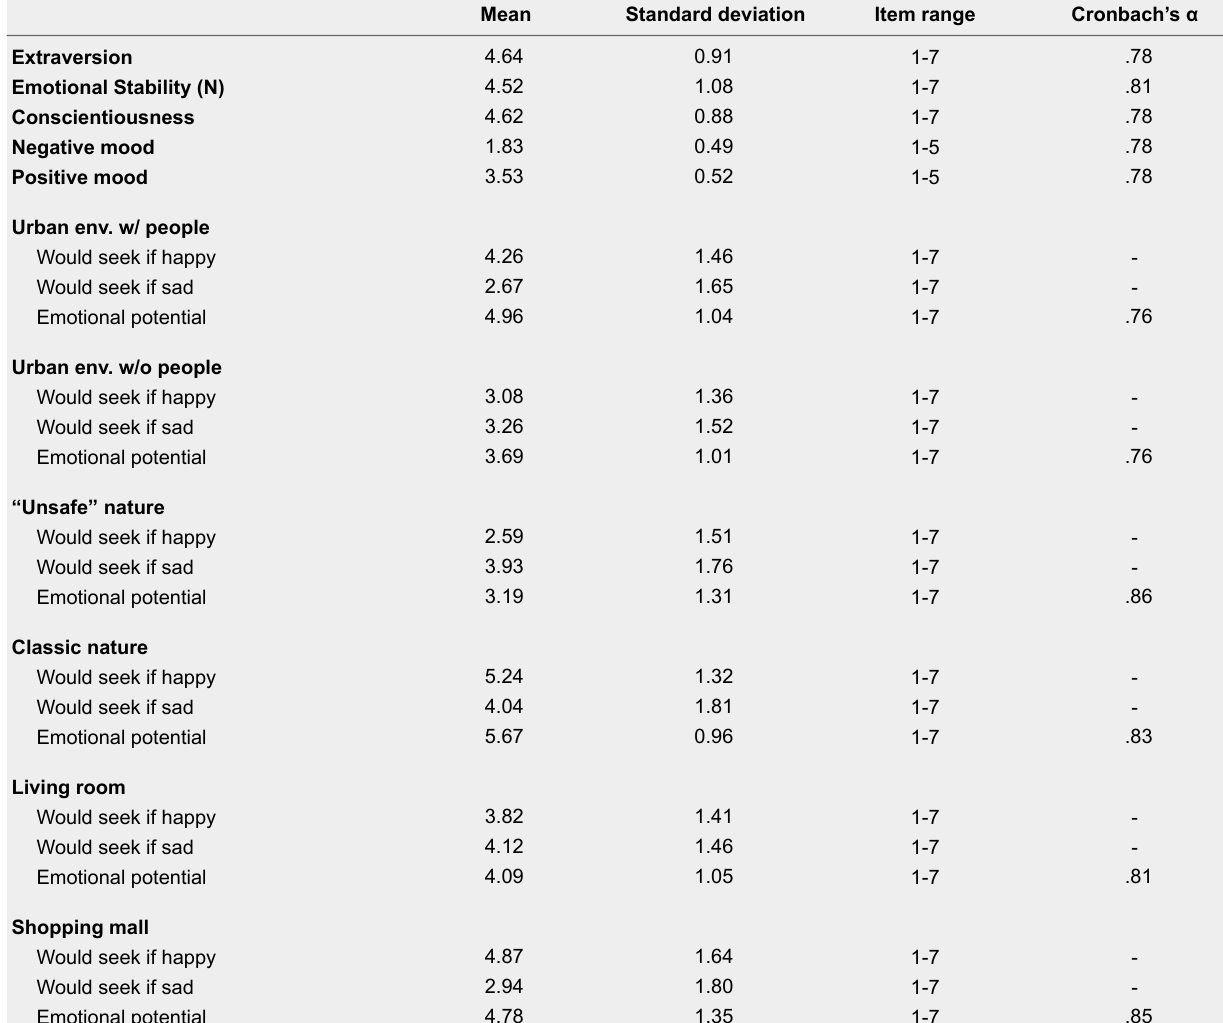
Means, Standard Deviations, and Item Ranges of